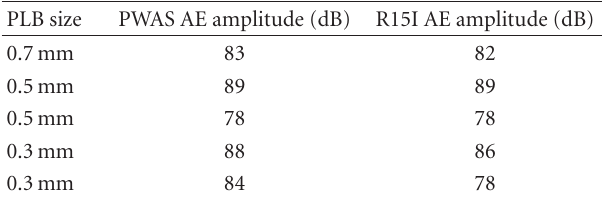
Table 1: AE detection on the 1.6-mm aluminum